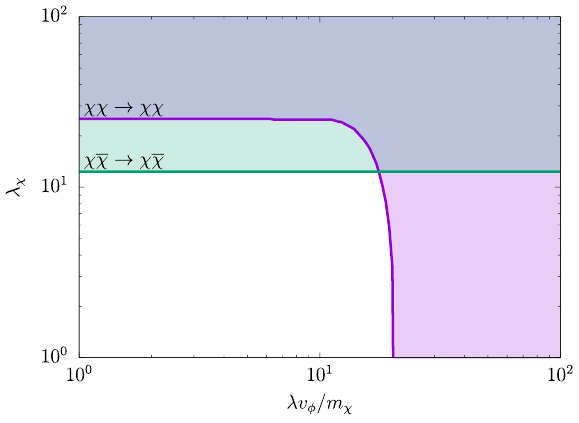
Figure 1 . Unitarity bounds obtained from the scattering processes χχ → χχ and χχ → χχ . Colored regions are